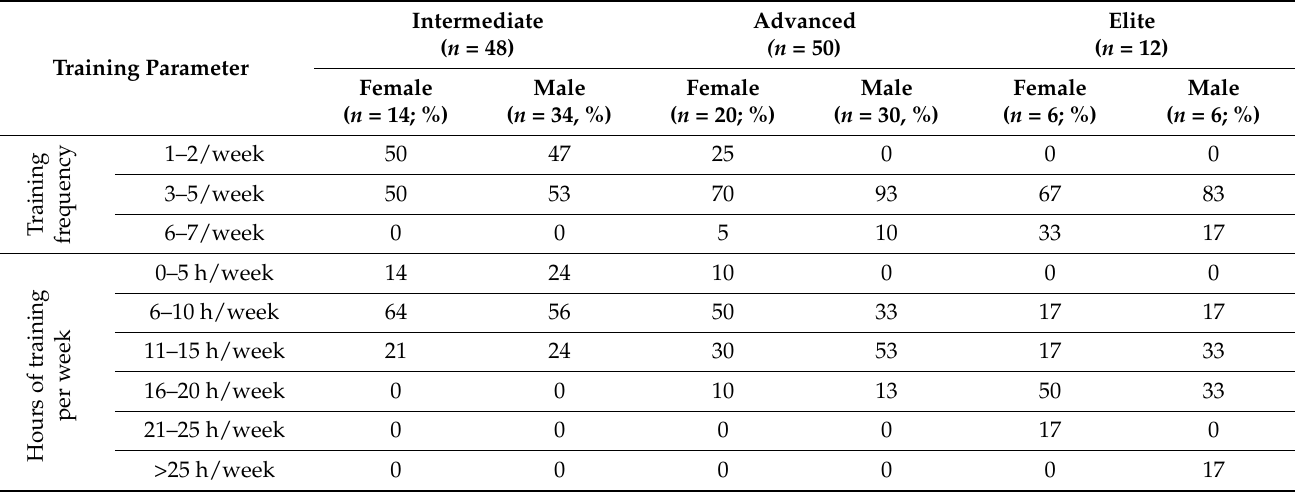
Table 2. Training frequency and duration per week depending on the climbing level and gender of the studied climbers, presented as the proportion of each cohort (%).